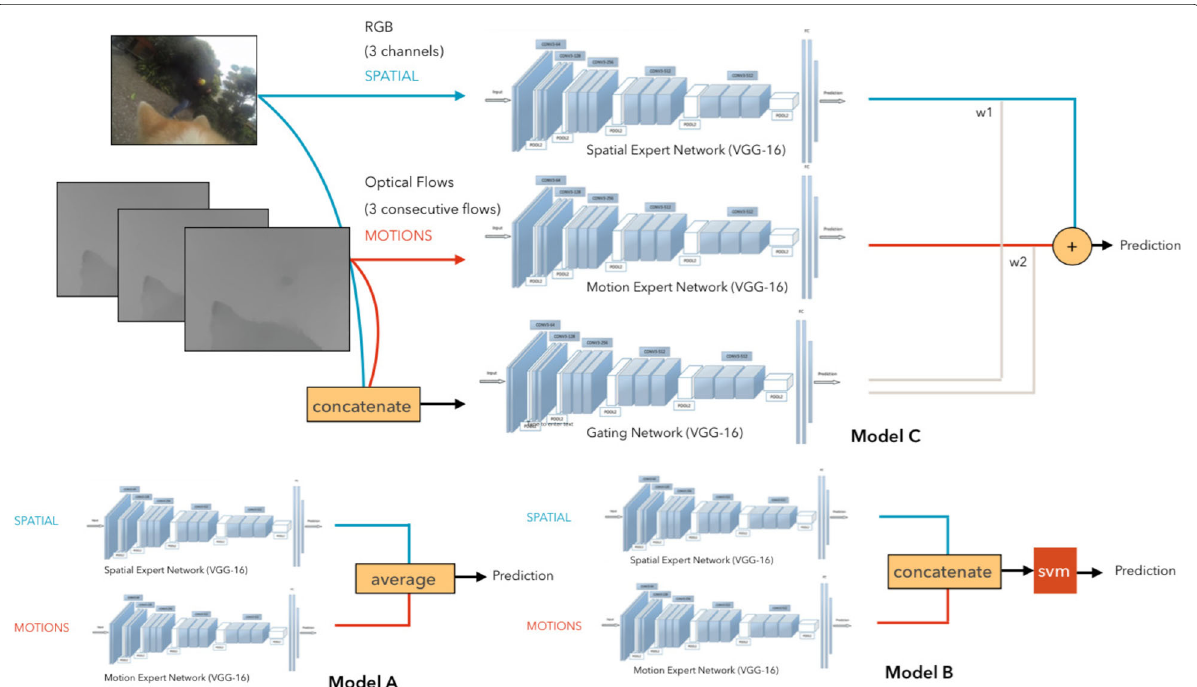
Fig. 1 Various models of the gating scheme. a Fusion by averaging. b Fusion by concatenation and SVM. c Gated network, similar to an expert